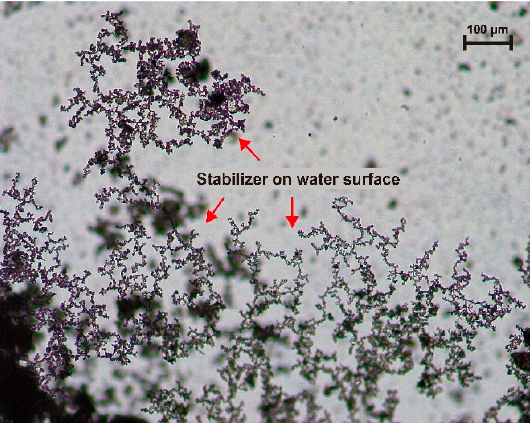
Figure 13. Stabilizer on the surface of water.